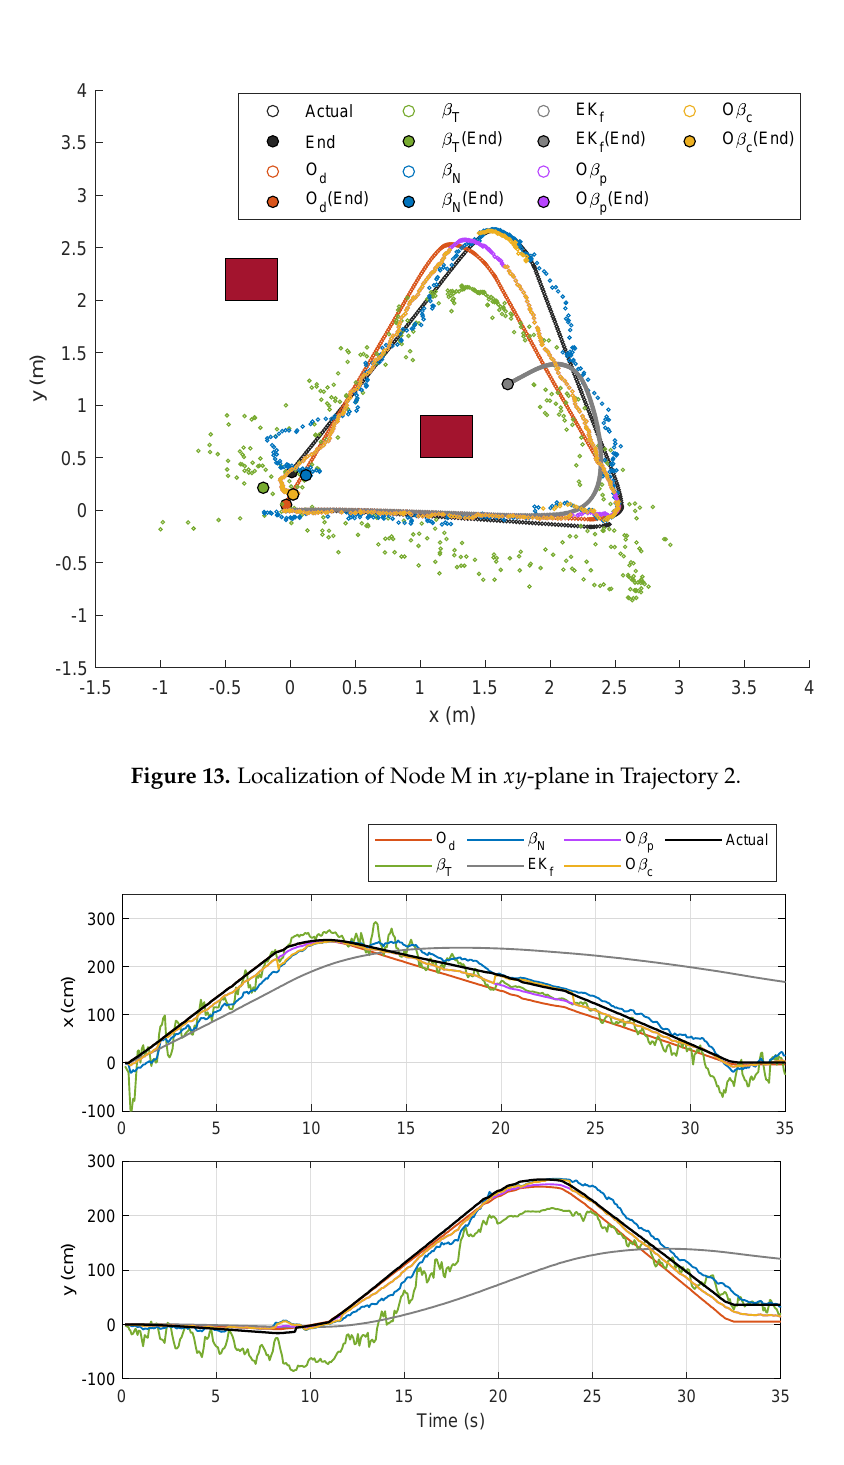
Figure 14. Localization of Node M in x - and y -directions in Trajectory